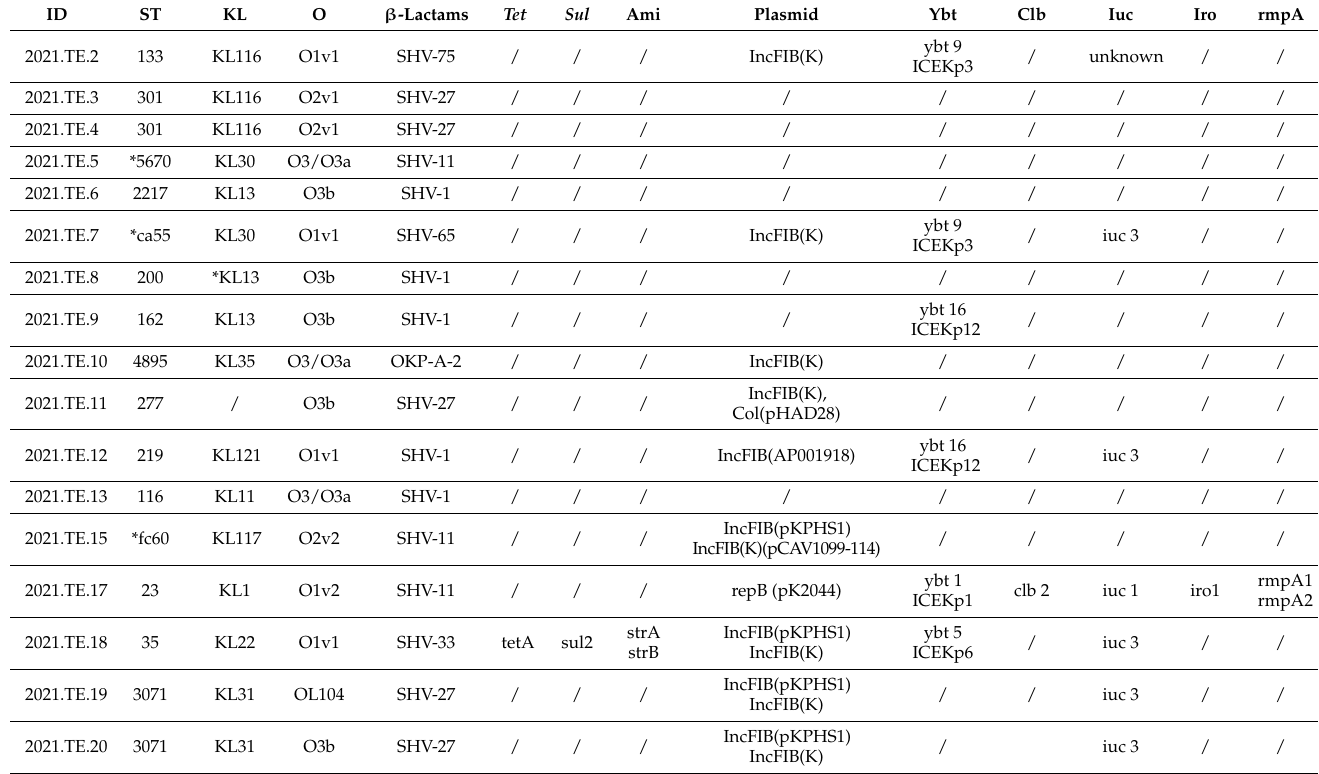
Table 2. Genomic characterization of 17 Klebsiella spp. strains analyzed in this study. ST: sequence type, KL: K locus, O: O locus, β -lactams: beta-lactams, Tet: tetracycline, Sul: sulfonamides, Ami: aminoglycosides, Ybt: yersiniabactin, Clb: colibactin, Iuc: aerobactin, Iro: